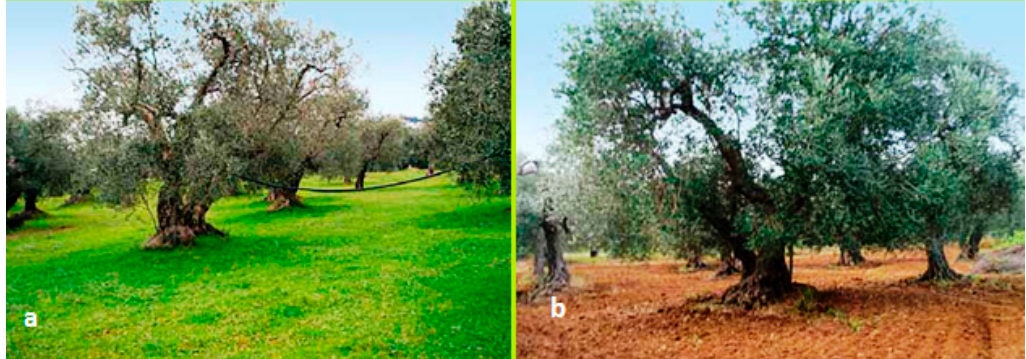
Figure 1. Sustainable -SS- ( a ) and Conventional -CS- ( b ) management systems in the two adjacent olive orchards.